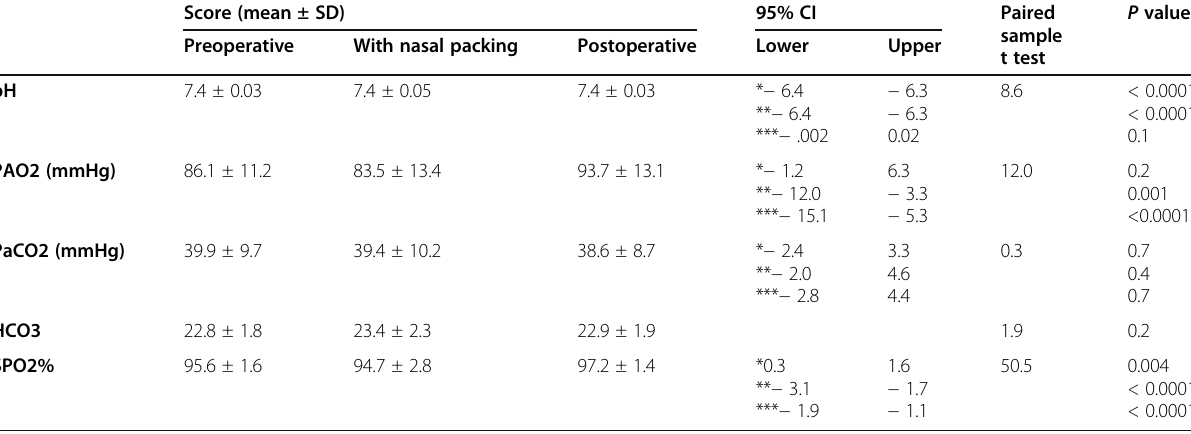
Table 4 Pre-operative with nasal pack and postoperative blood gases values Score (mean ±